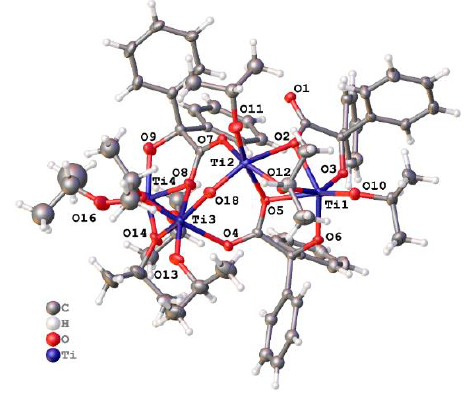
Figure 4. Asymmetric unit of 4 with atoms drawn as 50% probability ellipsoids. Disorder is not illustrated. Selected bond lengths (Å ) and bond angles ( o ): Ti(1)-O(5) 2.204(3), Ti(1)-O(3) 1.829(3), Ti(1)-O(2) 2.096(3), Ti(1)-O(6) 1.860(3), Ti(1)-O(10) 1.787(3), Ti(1)-O(12) 2.059(3), Ti(2)-O(5) 2.159(3),